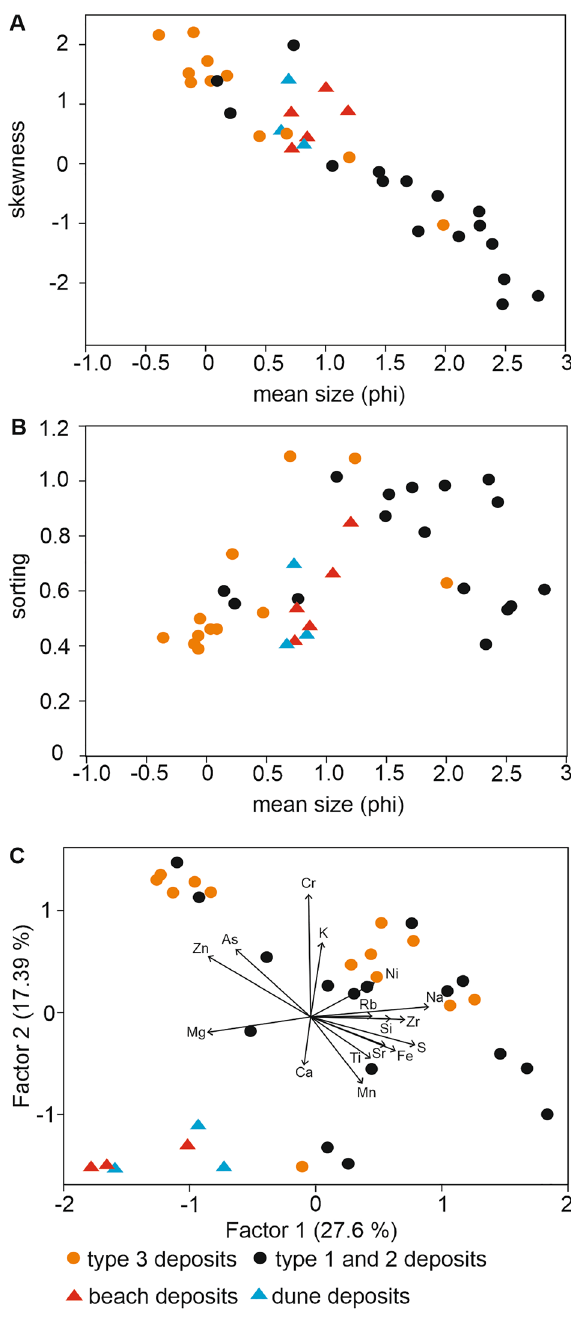
Figure 4. Grain-size and geochemical data. Samples were taken from all three types of sediments from the master core M12 from Mechelinki and modern beach and dune deposits. ( A ) Mean grain-size (in phi units) vs. skewness. ( B ) Mean grain-size (in phi units) vs. sorting. ( C ) Factor analysis of the geochemical data. The arrows accompanied by element symbols indicate the eigenvector values in the